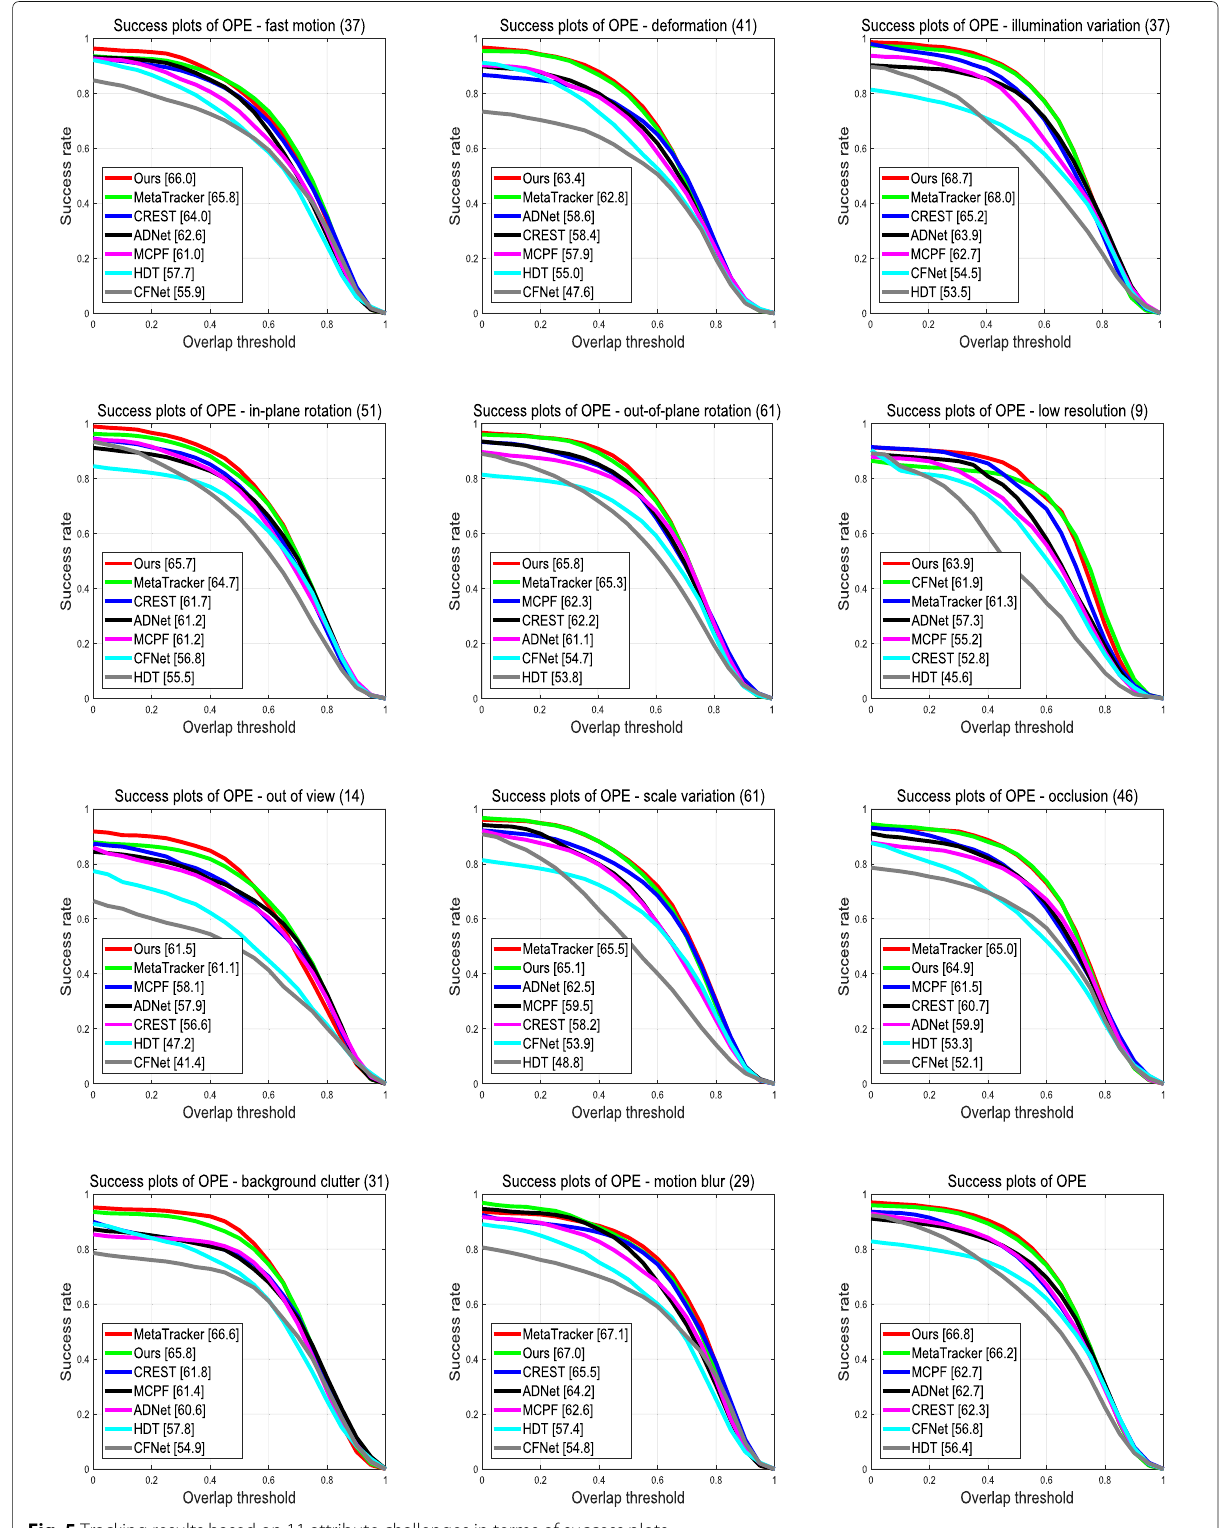
Fig. 5 Tracking results based on 11 attribute challenges in terms of success